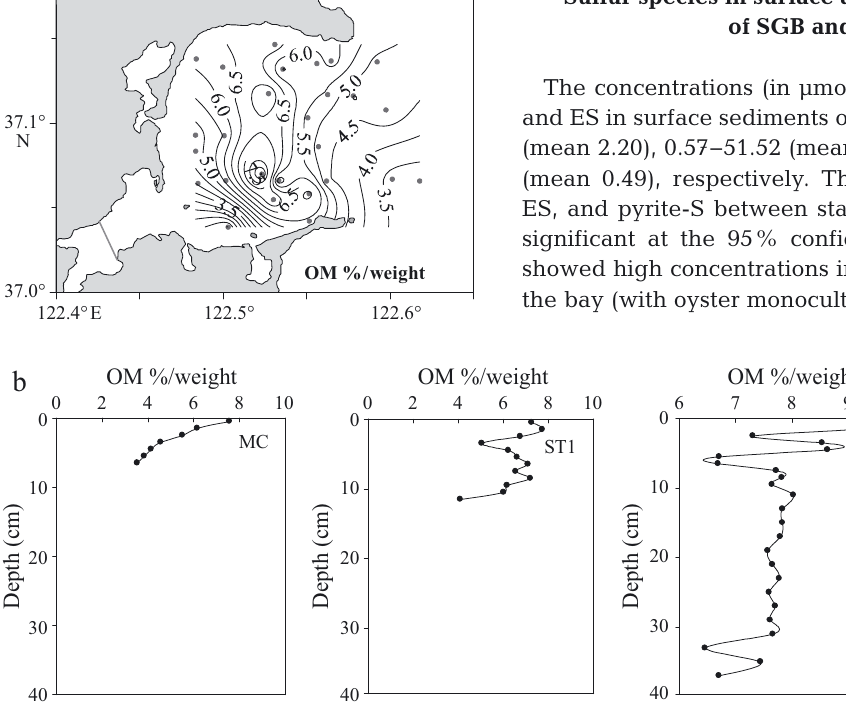
Fig. 3. Distribution of organic matter (OM) concentrations (% by weight) in (a) surface and (b) core sediments of Sanggou Bay and the Yellow Sea (see Fig. 1 for station